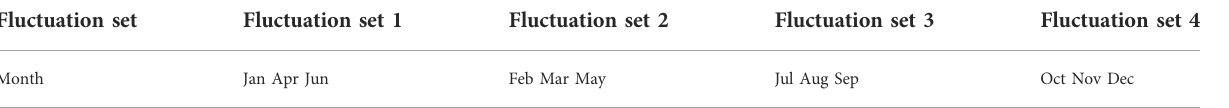
TABLE 1 Results of load similar fl uctuation set division.